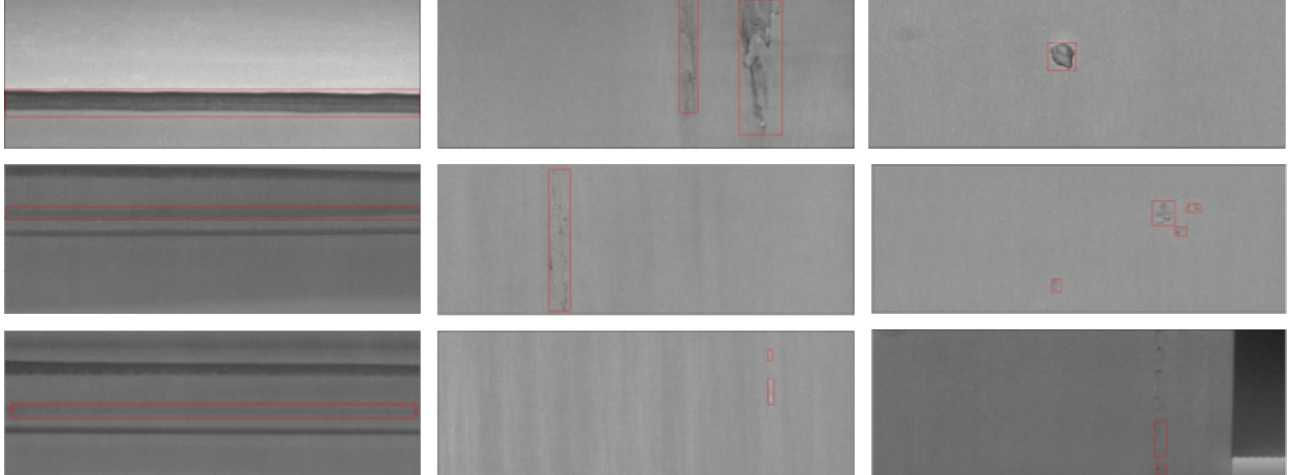
Figure 4. Defects with different severity levels. Each column represents a certain defect class with, for each row, a different severity. Top row shows severity level 3 defects, while the bottom shows level 1 defects. It is clear that level 3 defects are easier to detect than the lower-severity-level